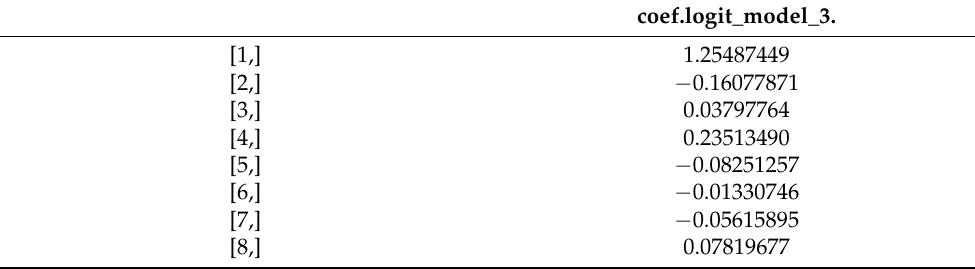
Table 8. Product of inverse matrix of D and coefficients of model 3.